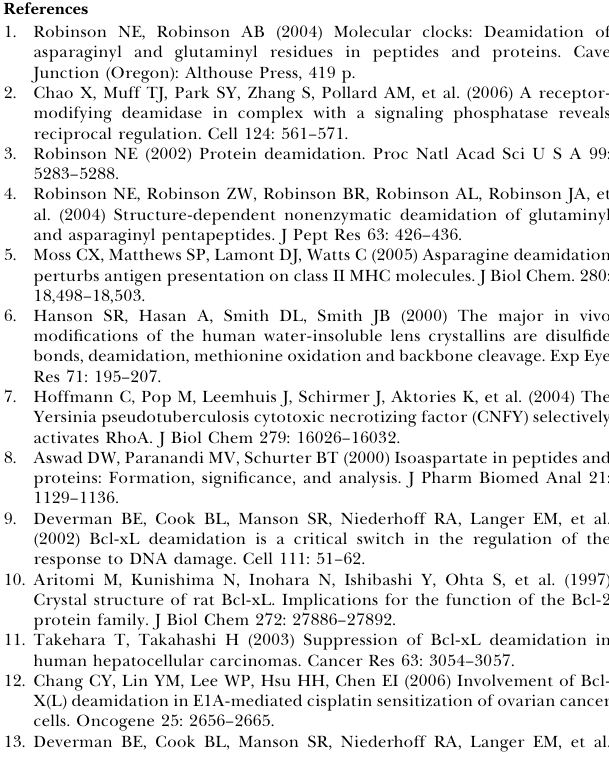
Figure S8. Inhibition of NHE-1 Synthesis by CHX or Inhibition of NHE-1 Function by DMA in B-CLL Cells Blocks DNA Damage– Induced Bcl-x L Deamidation (A) Replotting of data from Figure 6A to show the absolute